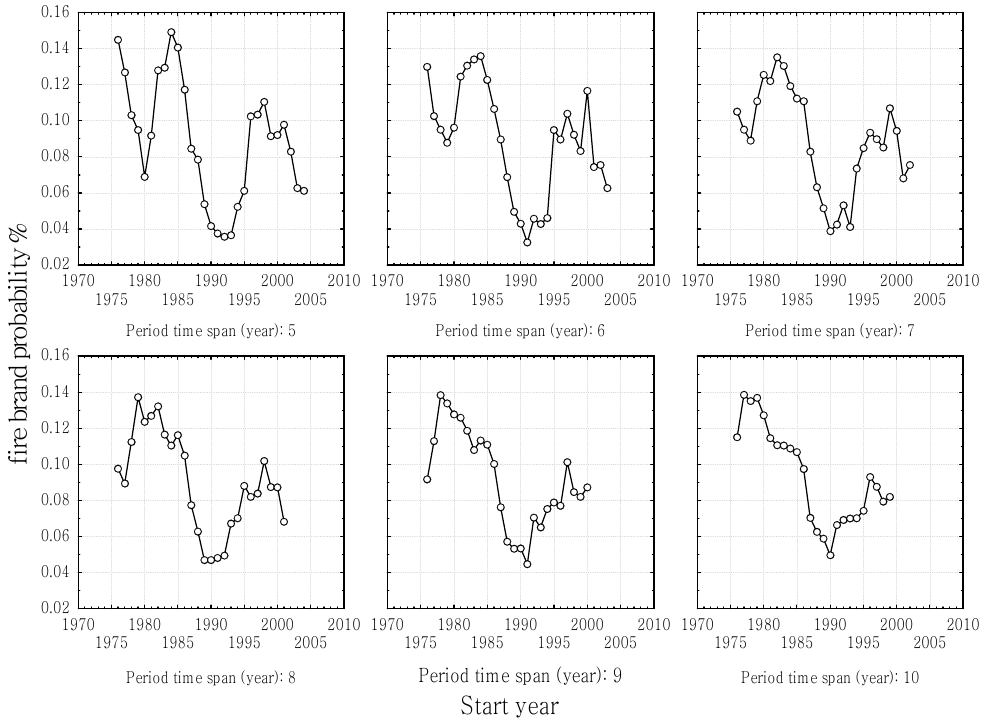
Figure 10. Fixed daily firebrand probability of periods spanning 5 to 10 years with different start years.